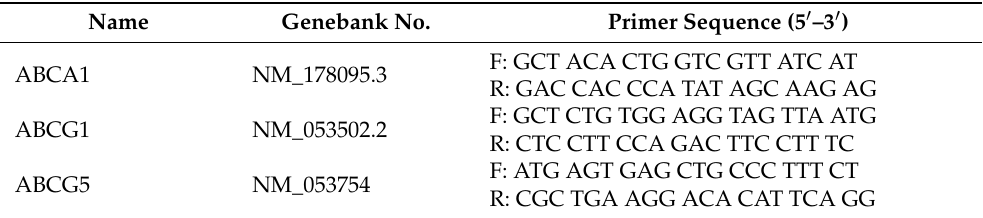
Table 2. Primer sequences used for